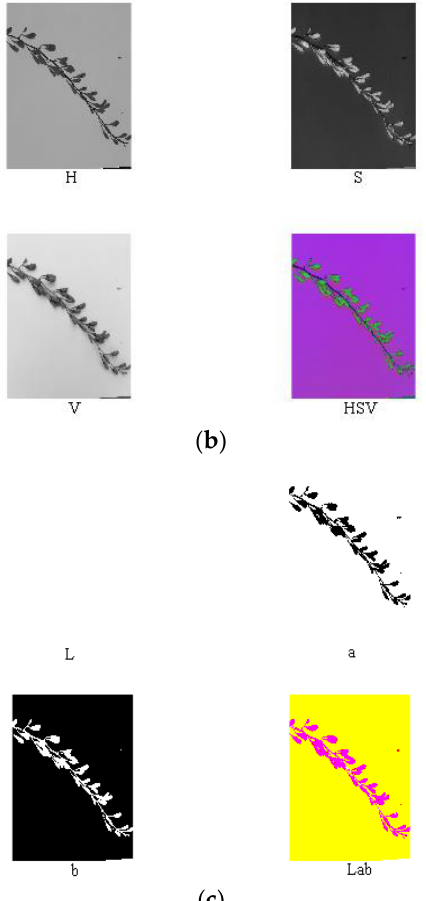
Figure 6. Extraction process of RGB ( a ), HSV ( b ), and lab ( c ) of the unripe fruit.